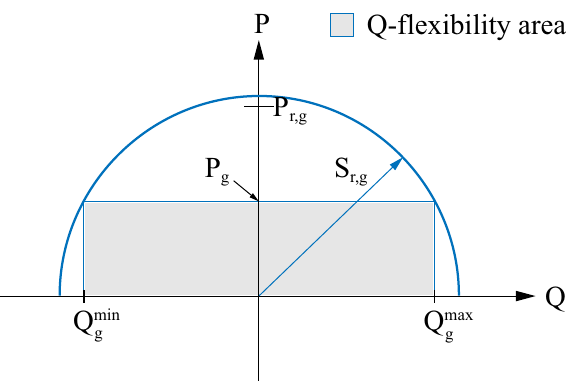
Fig. 5 DER reactive power capability curve based on Stock et al.